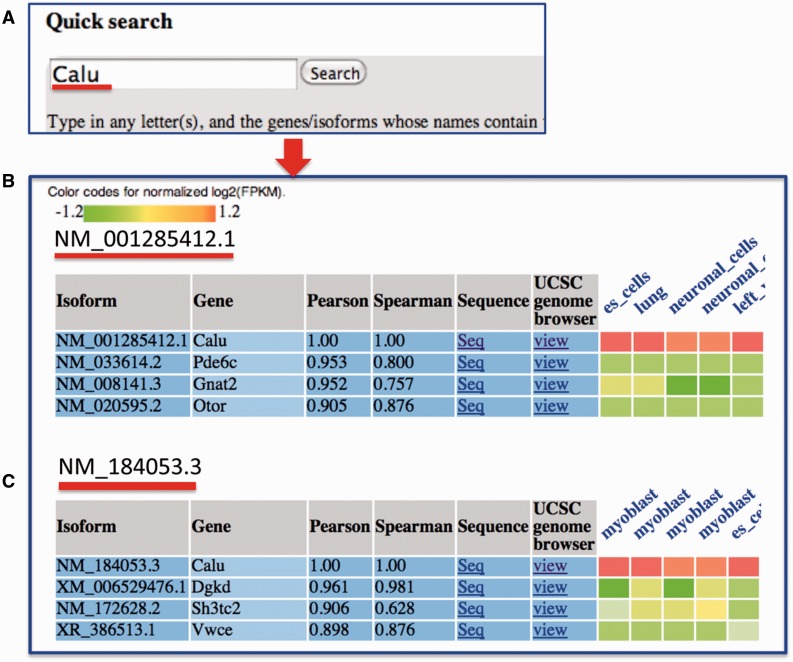
An example search for MIsoMine data portal from the ‘expression’ page and the returned results. (A) Querying the Calu (calumenin) gene. For illustration, (B) and (C) represent the normalized expression heat map of the top three correlated isoforms of NM_001285412.1 and NM_184053.3 of the Calu gene, respectively. In the heatmap in B and C, each column represents one sample and the tissue information is labeled on the top of each column. Original expression data of the top correlated isoforms can be retrieved from the webpage.